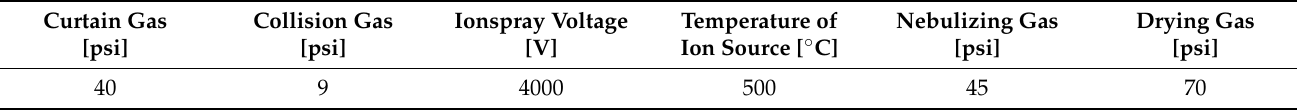
Table A3. Ion source parameters of the mass